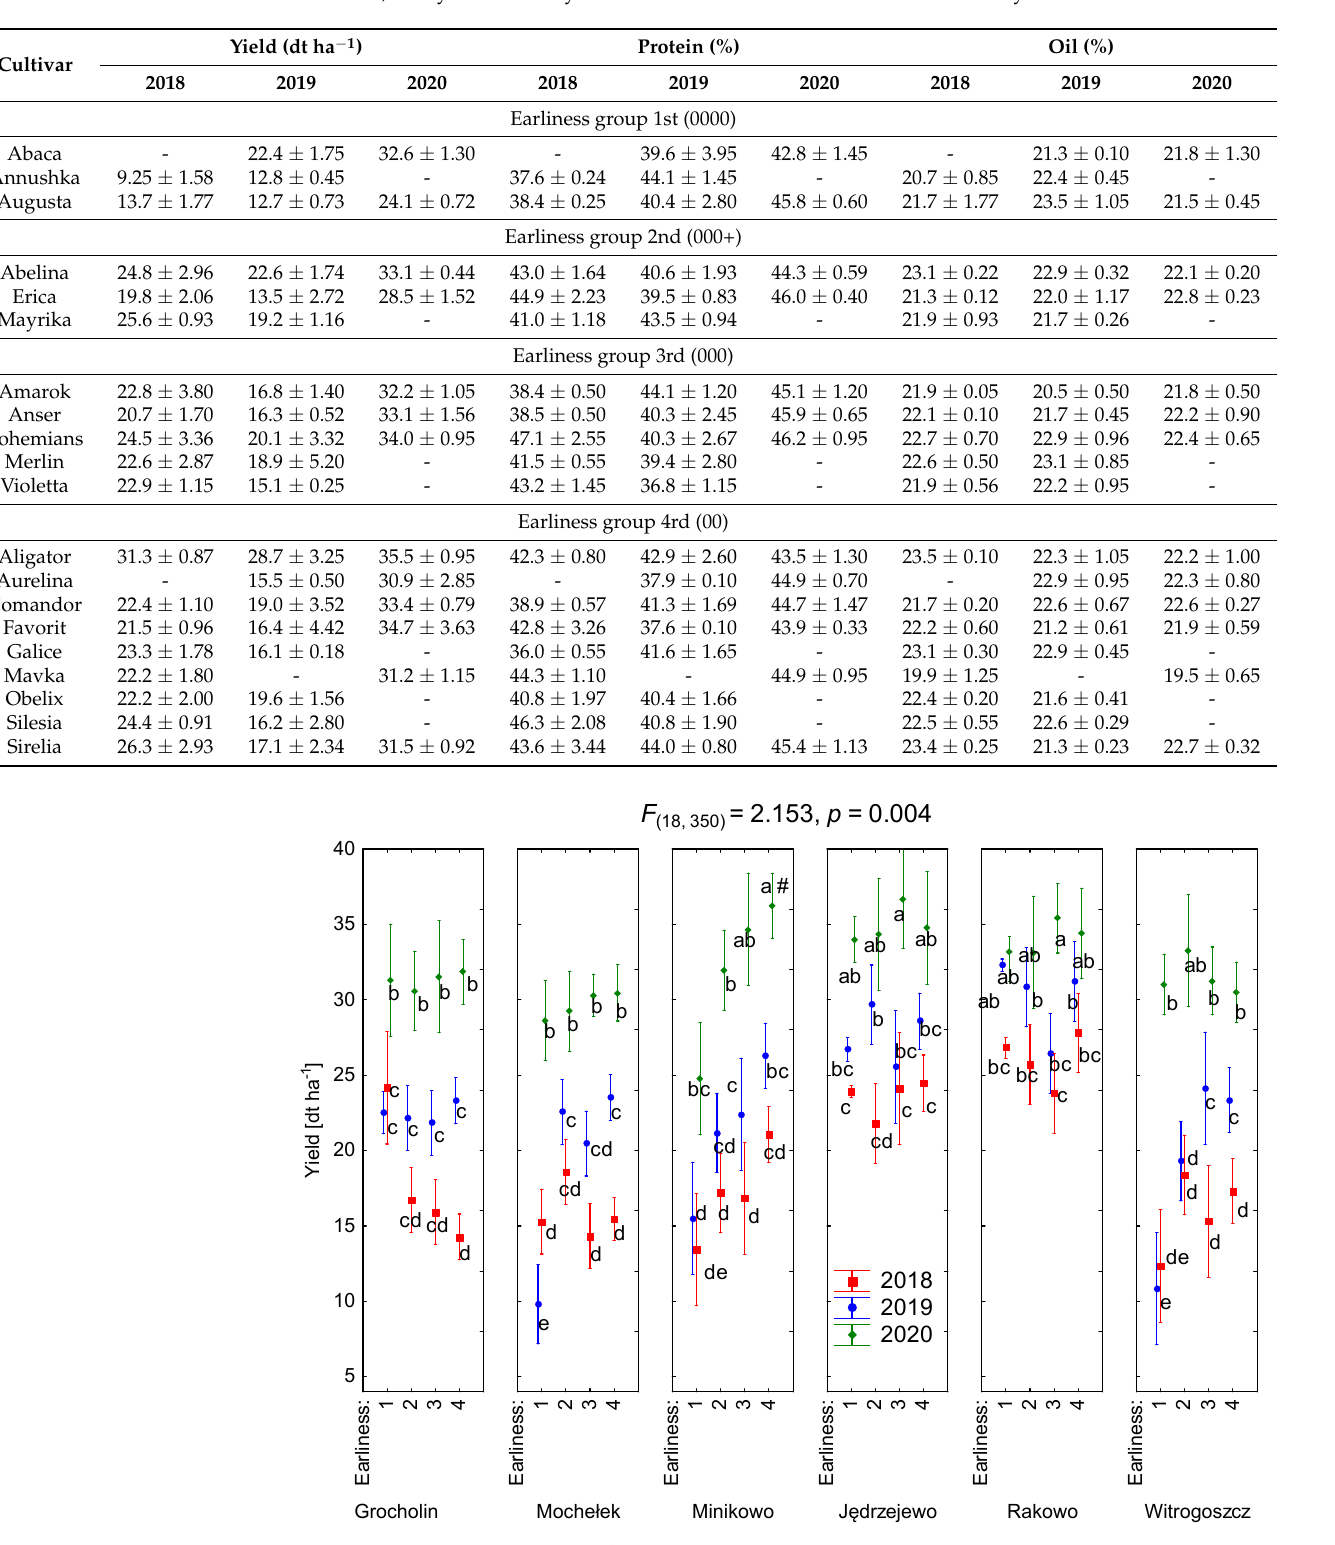
Figure 1. The seed yield (dt ha − 1 ) depending on the earliness of soybean. Means ± confidence intervals ( p = 0.95) from cultivars planted in 2018–2020 in Central Poland. # Various letters indicate the heterogenous groups according to the HSD Tukey’s test at p =